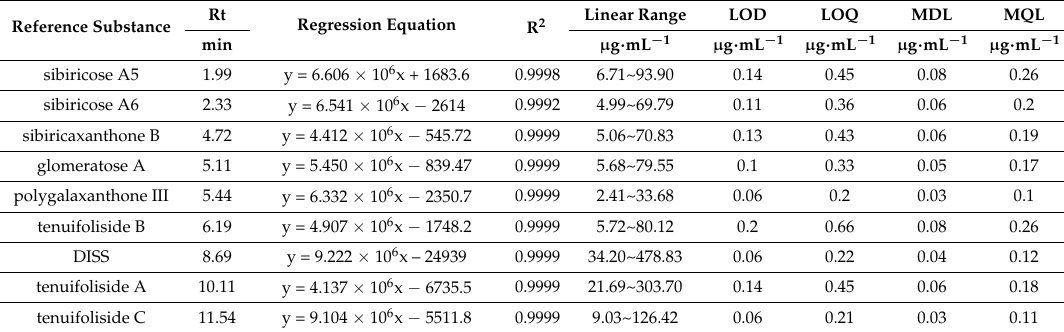
Table 1. Calibration curves for the nine compounds determined. LOD: limit of detection, LOQ: limit of quantification; MDL: method detection limit; MQL: method quantitation limit. Rt Regression Equation Reference Substance R 2